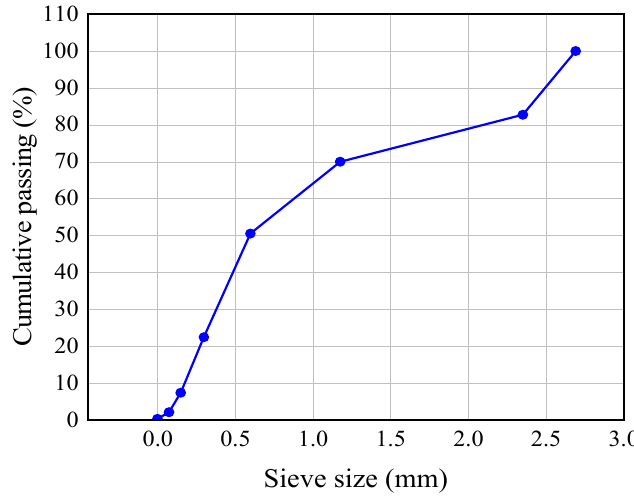
Figure 1. Grading curve of natural river sand.